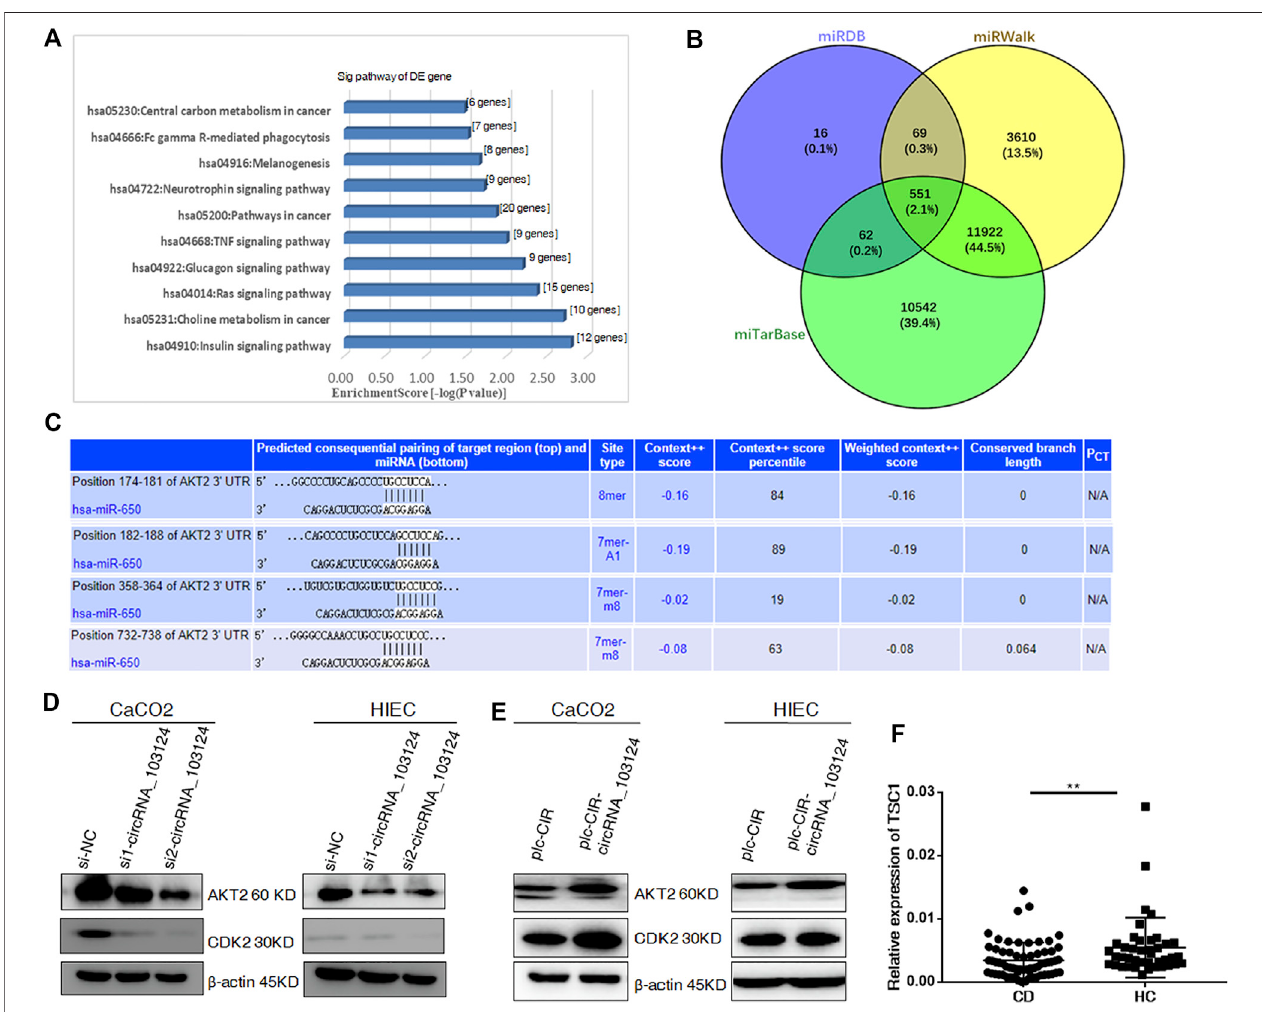
FIGURE 3 | Hsa_circRNA_103124 targets AKT2 by sponging hsa-miR-650. (A) GO and KEGG pathway analyses were performed to predict the biological functions of hsa_circRNA_103124 using DAVID 6.7. (B) The intersection of the downstream genes of hsa-miR-650 in the miTarBase, miRDB and miRWalk databases wasobtaininVenny2.1. (C) SubsequentpairingoftargetmiRNAsandgeneswaspredictedusingTargetScan. (D) RelativeexpressionofAKT2andCDK2wasdetected usingwestern-blottingfollowingthetransfectionofthehsa_circRNA_103124siRNA,andnormalizedto β -actin.si-NC,cellstransfectedwiththenegativecontrolof hsa_circRNA_103124 siRNA; si1-circRNA_103124, si2-circRNA_103124, cells transfected with the siRNA targeting hsa_circRNA_103124. (E) Relative expression of AKT2 and CDK2 was detected using western-blotting following hsa_circRNA_103124 overexpression, and normalized to β -actin. plc-CIR, cells transfected with the plasmid control plc-CIR; plc-CIR-circRNA_103124, cells transfected with the hsa_circRNA_103124 overexpression plasmid plc-CIR-circRNA_103124. (F) Relative expression of TSC1 in patients with CD ( n (cid:2) 60) and HCs( n (cid:2) 40) was performed by RT-QPCR. ** p < 0.01.